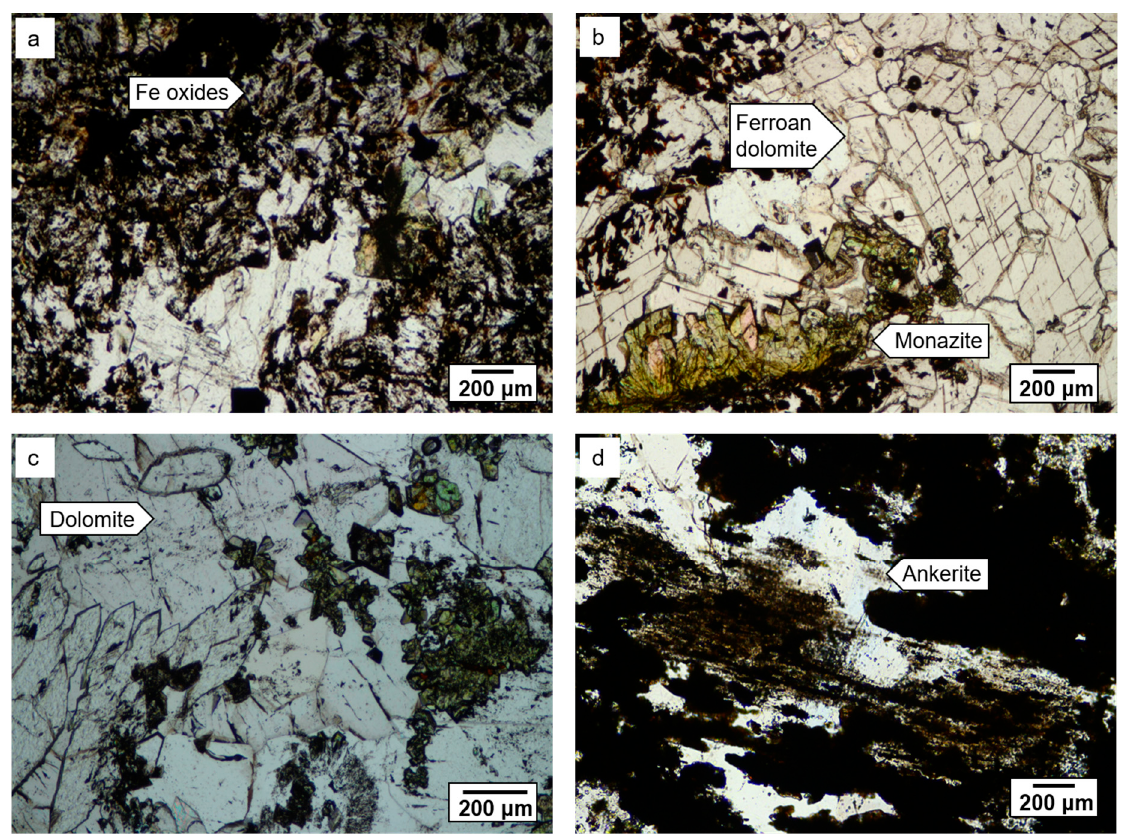
Figure 6. Photomicrographs (plane-polarized light) showing the dominant carbonate mineralogy of ( a ) unmineralized dark carbonatite, ( b ) mineralized dark carbonatite, ( c ) light carbonatite, and ( d ) apatite-rich carbonatite.